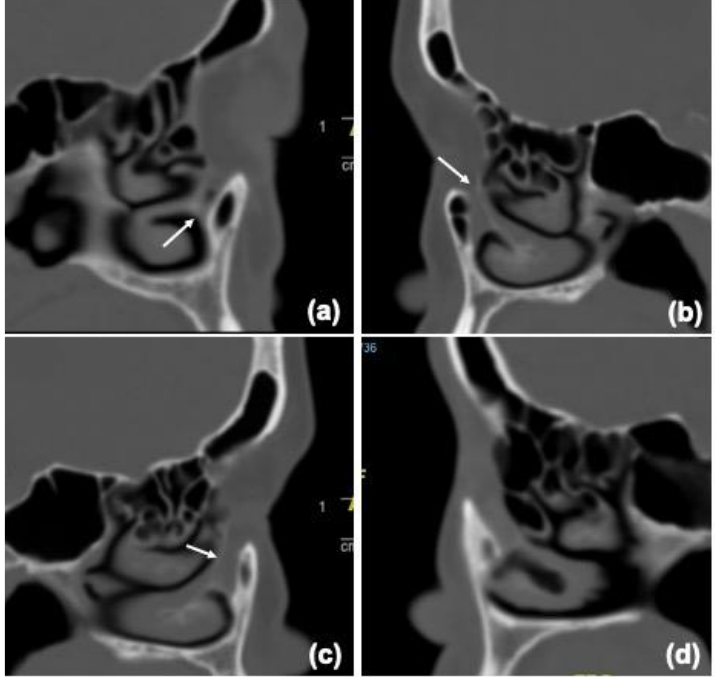
Figure 2. Four shapes of the BNLD. ( a ) Funnel type: narrow point near the exit level. ( b ) Flare type: narrow point near the entrance level. ( c ) Hourglass type: narrow point between the exit and entrance levels. ( d ) Columnar type: evenly distributed along the path.